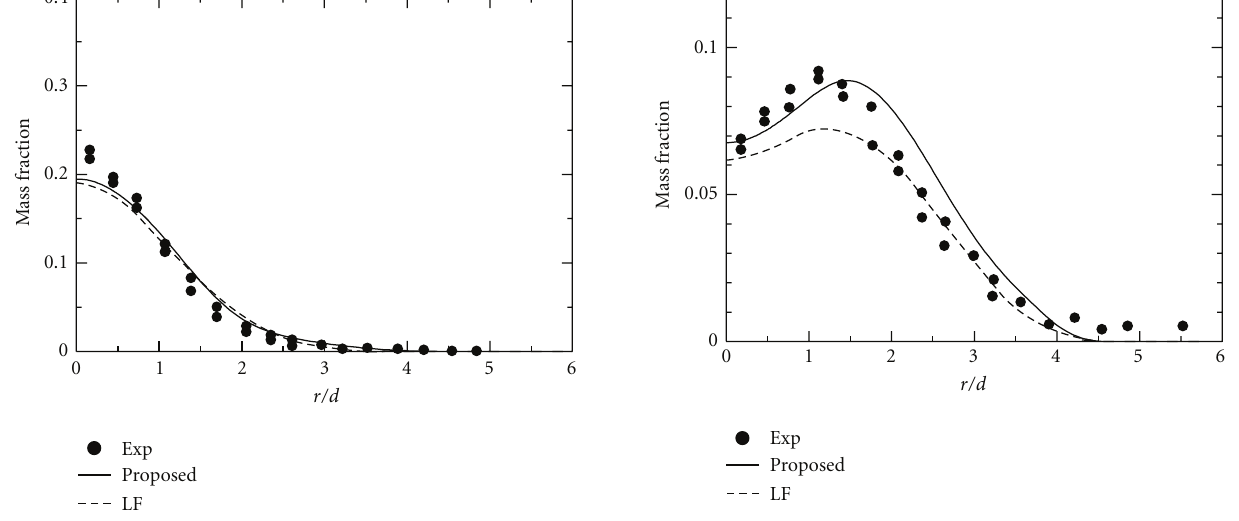
Figure 19: Radial mass fraction of CO at x/d = 20.